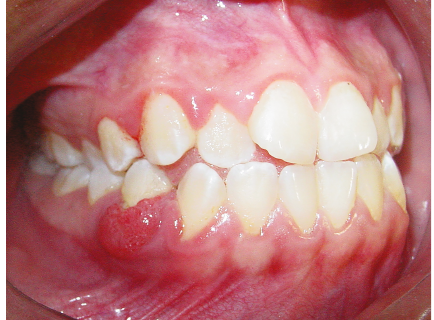
Figure 2: Edema around the 44 region.